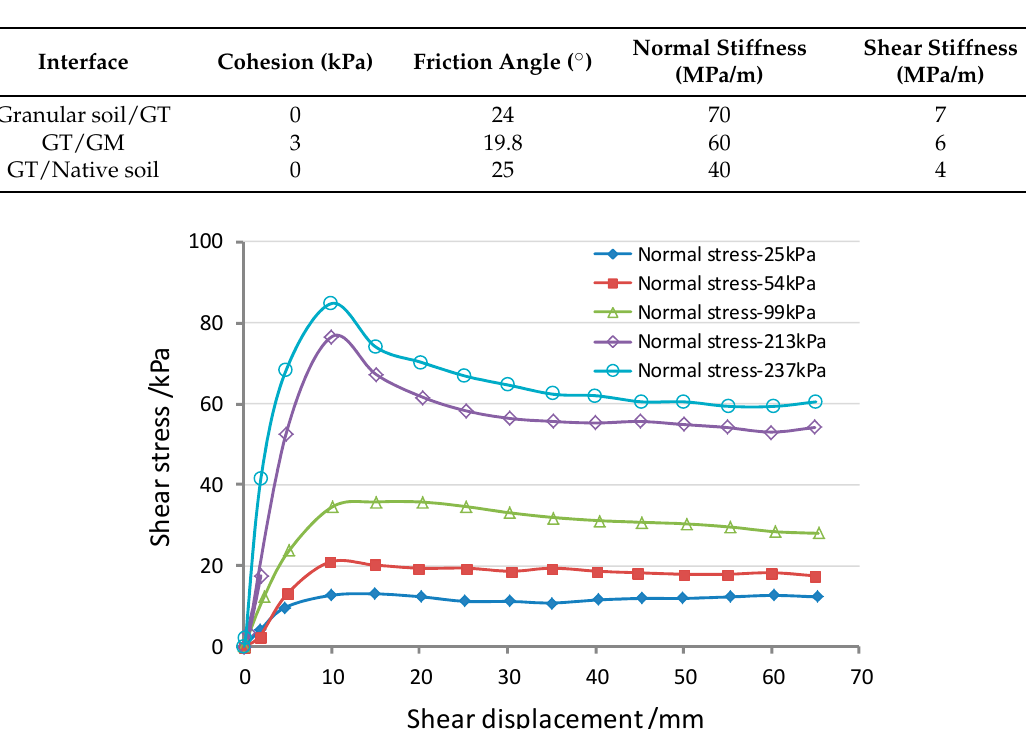
Table 3. Friction parameters of the various interfaces (modified from Lin, 2009 [15]).